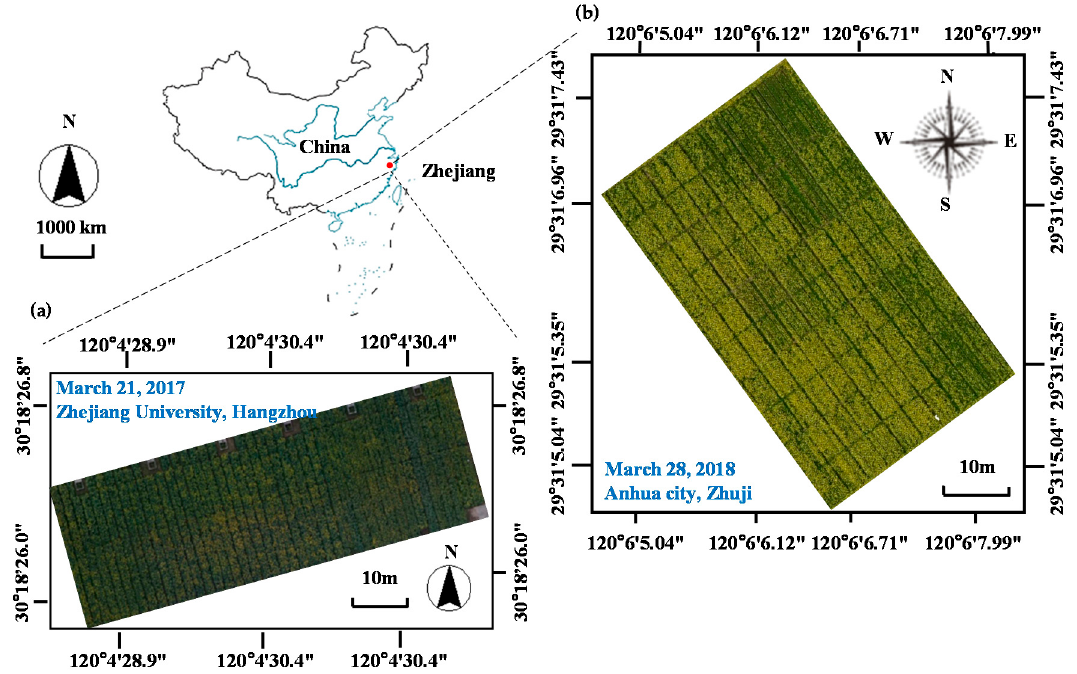
Figure 1. The general locations of two experimental sites and the overview of the images obtained by unmanned aerial vehicle (UAV) remote sensing platform for the oilseed rape fields at Zhejiang University on 21 March 2017 ( a ) and at Anhua city, Zhuji on 28 March 2018 ( b ), respectively.